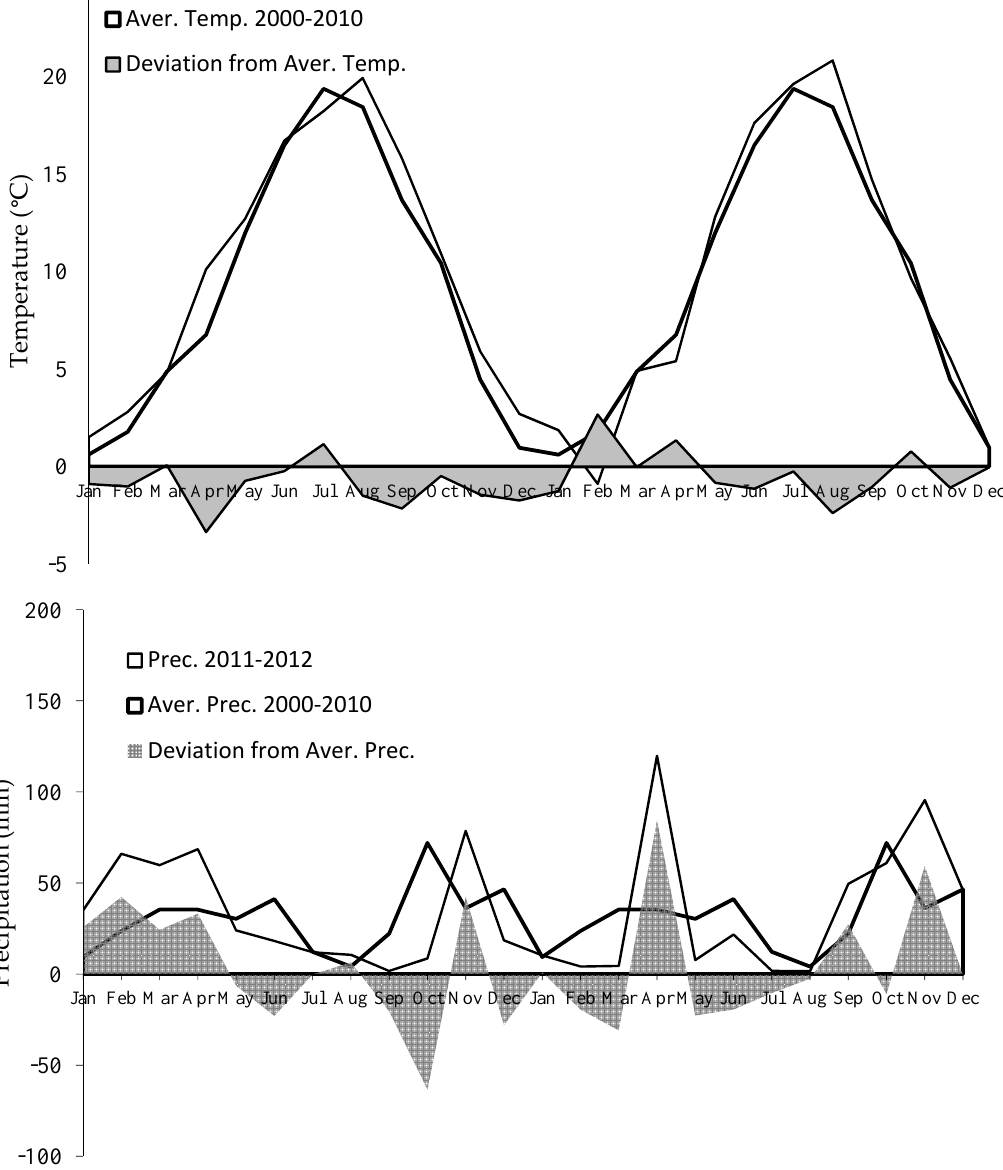
Figure 2. Temperature (Temp.) and precipitation (Prep.) values recorded during 2011 and 2012 in comparison with average (Aver.) precipitation and temperature values of the last 10 years for the study area. Shaded area represents the deviation between average values and 2011–2012 values.